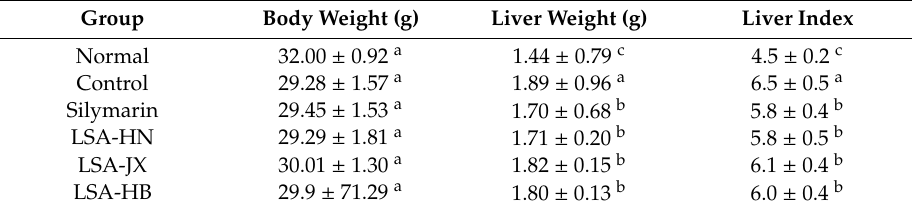
Table 3. E ff ects of alkaloids from Lotus plumules on body weight, liver weight and liver index of mice with hepatic injury induced by carbon tetrachloride ( N = 10).